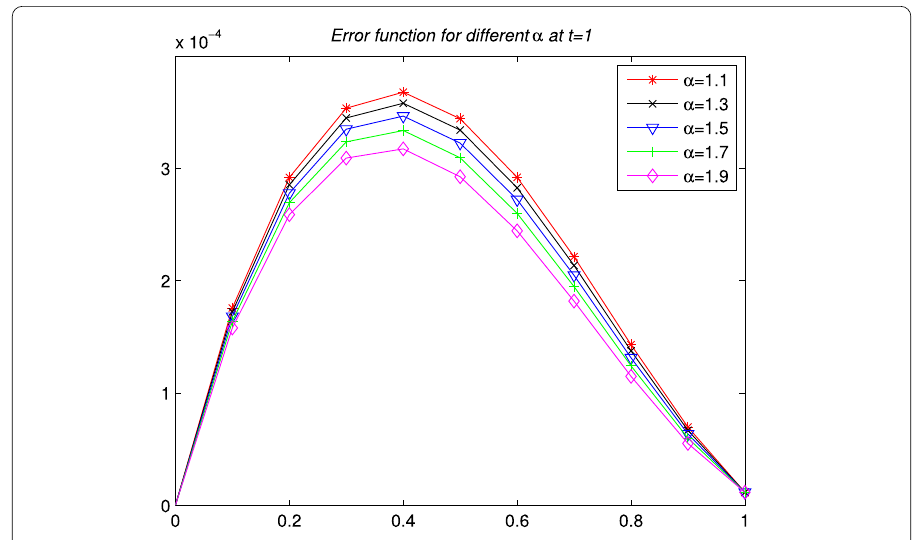
Figure 2 Error function for N = 11, n = 4, M = 70 and different α at t = 1 corresponding to Problem